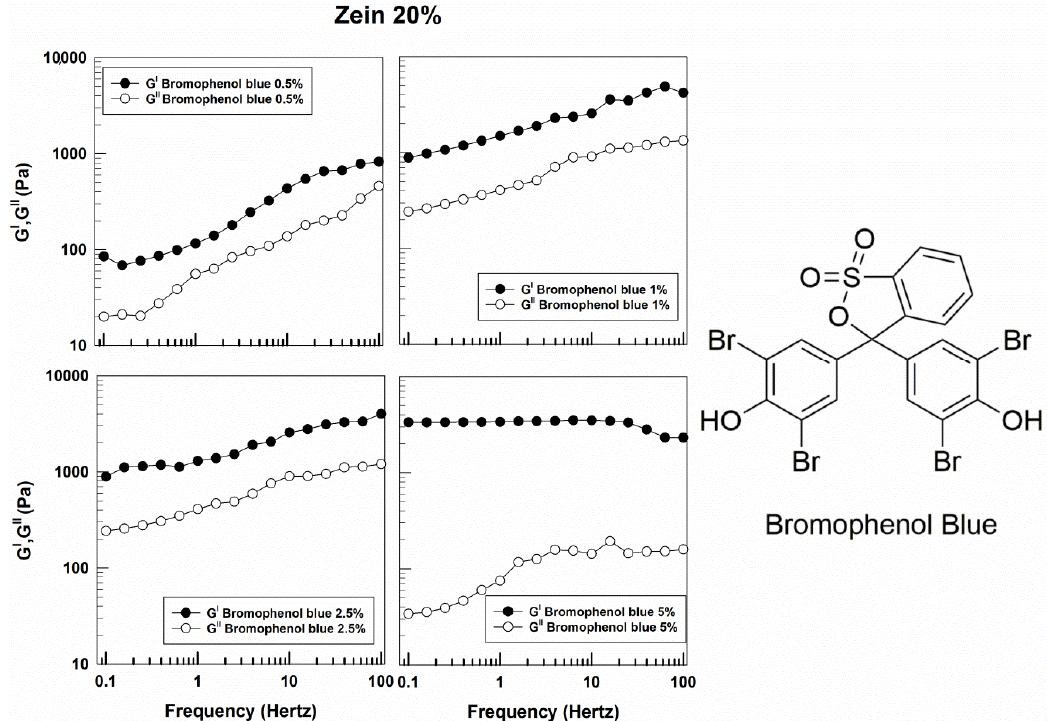
Figure 6. Evaluation of the elastic (G ′ ) and viscous (G ′′ ) moduli of zein gels prepared using 20% w/v of protein and containing bromophenol blue (0.5%, 1%, 2.5%, 5% w/w ) as a function of the frequency.